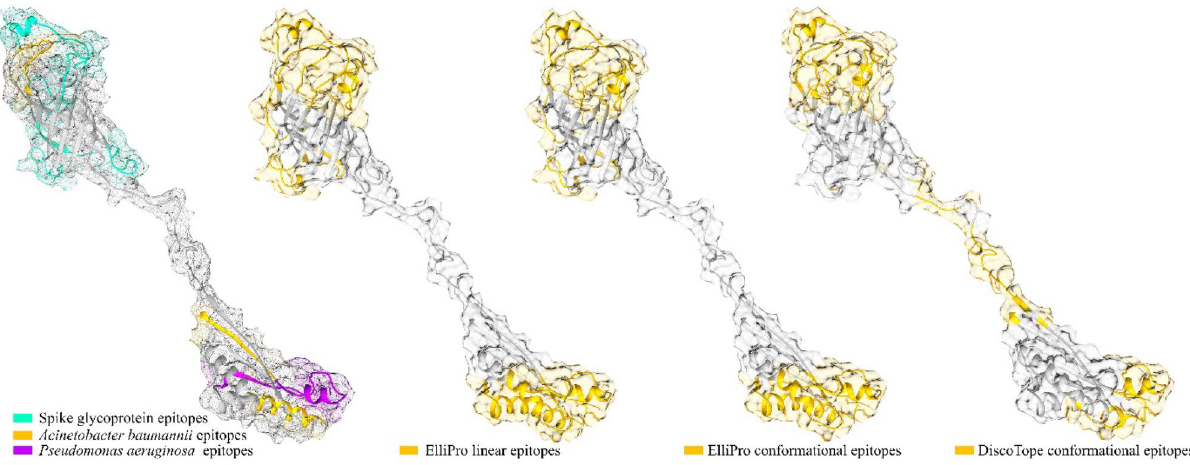
Figure 6. Construct epitopes. The tertiary structure of the engineered construct and the B-cell epitopes. Cartoon representation of the engineered construct is presented by gray color and transplant surface. The epitopes are assigned by colors. From left to right the first image is the construct and the embedded epitopes. Three other images show the located (predicted) epitopes of engineered construct by online servers. The color codes are shown below each image, golden ribbons are predicted epitopes. The locations of predicted epitopes in comparison to the location of embedded epitopes show the accuracy of the engineering approach. The color scheme is consistent with Fig.